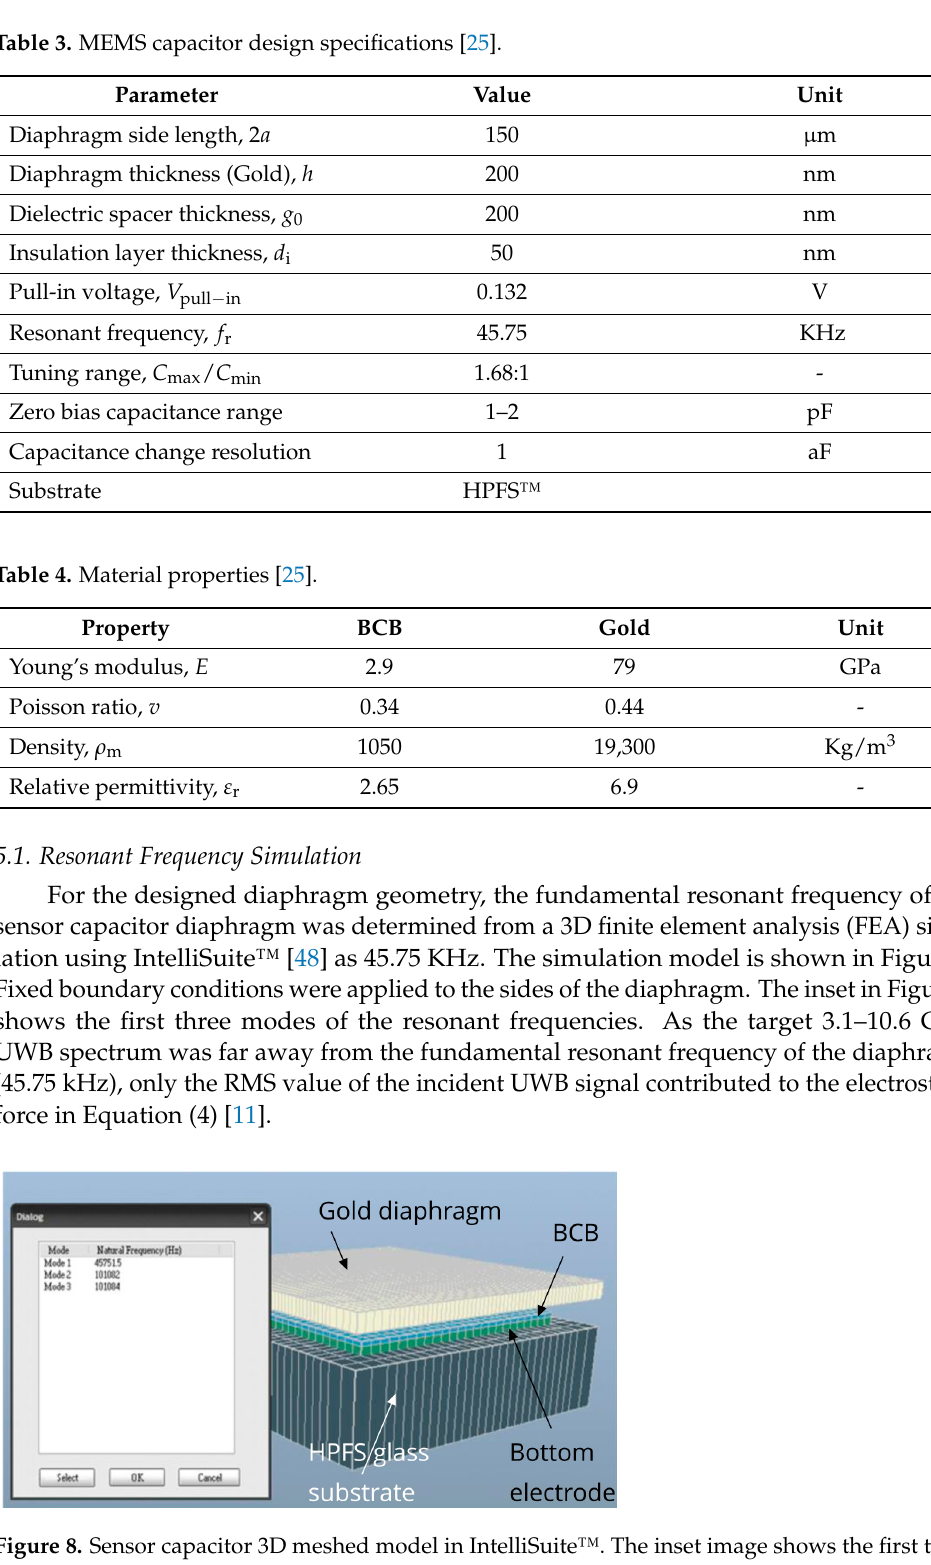
Figure 8. Sensor capacitor 3D meshed model in IntelliSuite™. The inset image shows the first three modes of resonant frequencies. modes of resonant